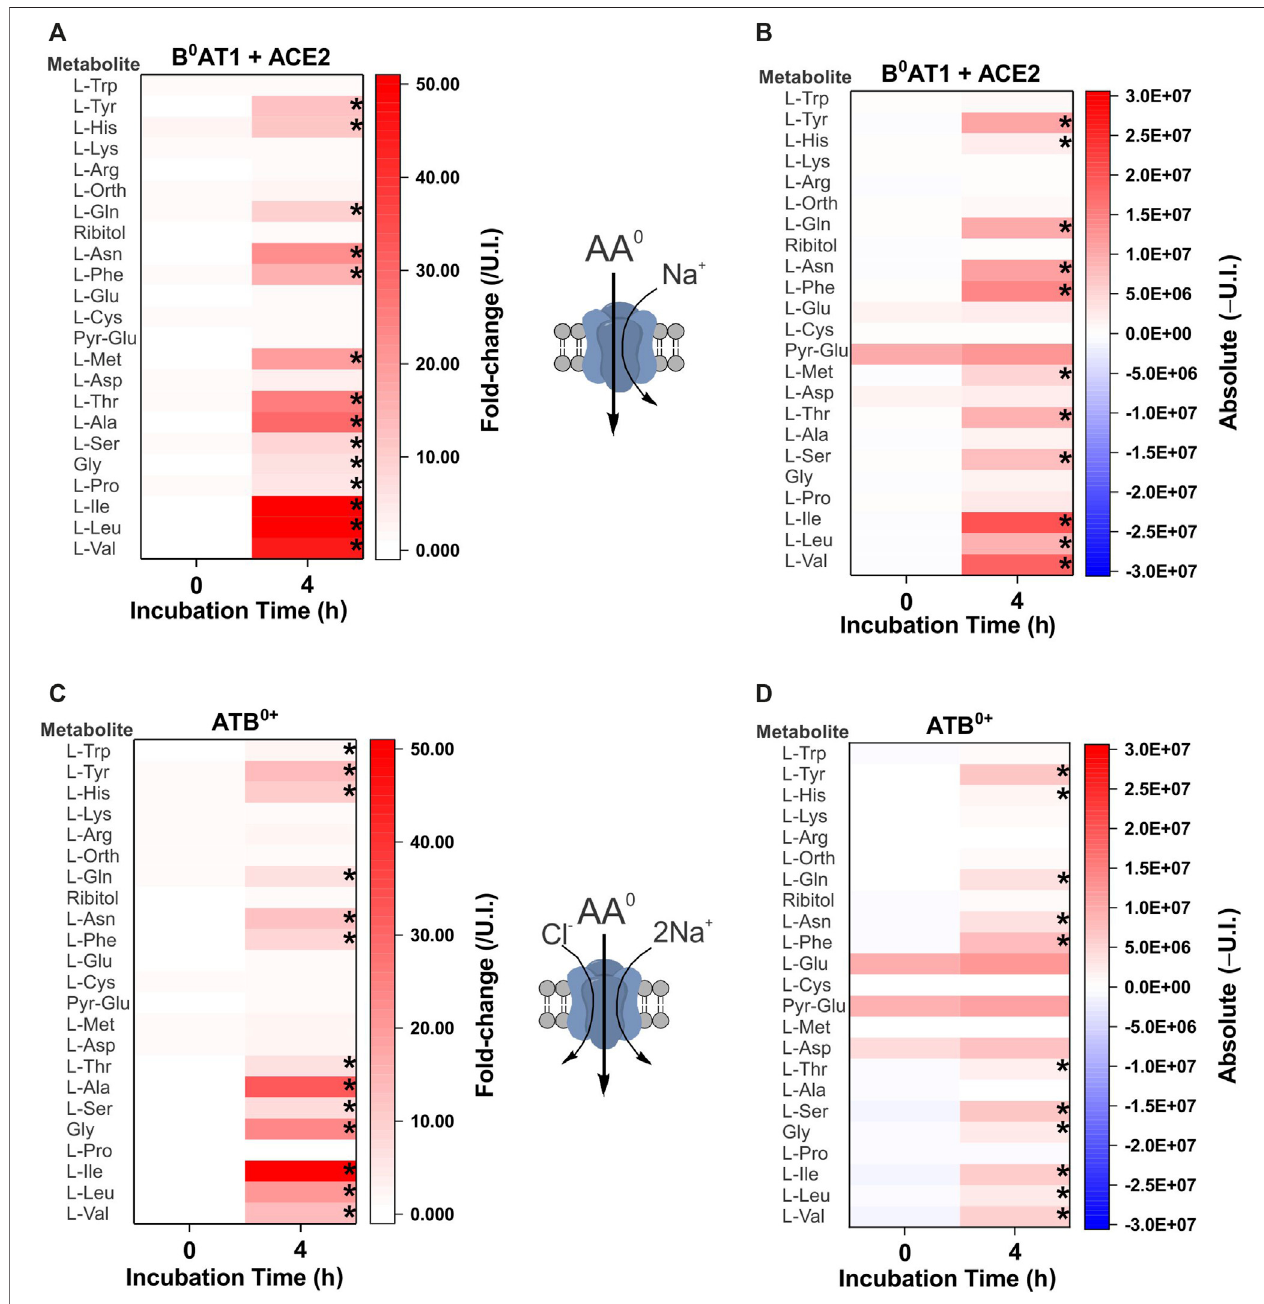
FIGURE3| Comprehensiveaminoacid fl uxpro fi leofbrushborder epithelialtransporters. Oocytes wereeachinjectedwith10 ng cRNAofB 0 AT1plus ACE2 (A,B) or ATB 0,+ (C,D) or remained un-injected (controls). After 4 days of incubation in OR2 + (pH 7.8), oocytes were incubated for 4 h in modi fi ed L-15 medium before metaboliteextractionandanalysis.Heat-mapsshowfold-change (A,C) orabsolutepeak (B,D) differencerelativetoun-injectedoocytes.Acartoonofeachtransporter ’ s knownspeci fi cityand stoichiometry isshownbetweentheheatmaps.Thefold-change (A,C) ateachtimepoint(0and 4 h)wascalculatedbydividingtheabsolute signal for each amino acid by the corresponding signal from un-injected oocytes, thereby taking account of any natural fl uctuations due to endogenous acquisition pathways during incubation. The absolute value heat-maps (B,D) were generated by subtracting the signal of un-injected oocytes from the signal in transporter expressingoocytesateachtimepoint(0or4 h).Amoreintenseredforthesameaminoacidat4 hindicatesactiveaccumulation. Pyro-glutamicacid(2-oxo-proline)and ornithine were included in all heat maps as they are known GC-MS derivatives of glutamate and arginine, respectively. The internal standard ribitol was also included in each heat map as a negative control to indicate any deviation from fold-change of 1 ± 0.1. * Indicates a difference in the means between the two time points at the p < 0.05 level using a paired t -test as calculated from the absolute mass spectrometer raw values. The fi gures are a representative example of 3 experiments with n (cid:2) 12 transporter-expressing and un-injected oocytes per replicate, e (cid:2)